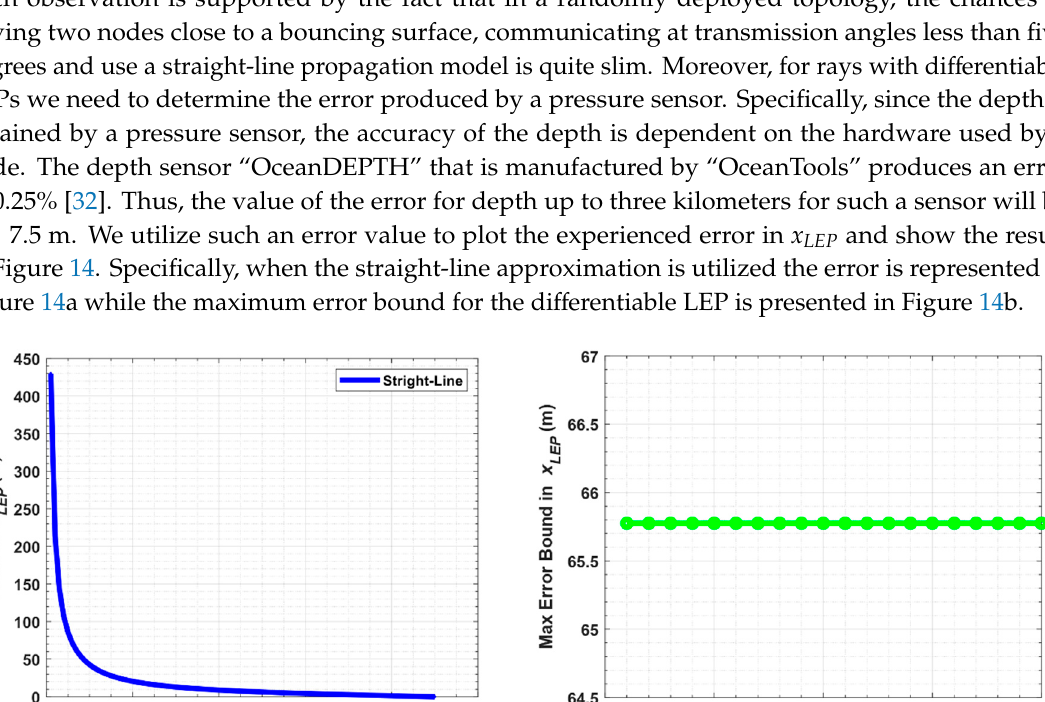
Figure 14. The error observed in the 𝑥 (cid:3013)(cid:3006)(cid:3017) where ( a ) is the error when equation (5) used while ( b ) shows the maximum error bound when Equation (6) is used. Both figures assume that the error by the shows the maximum error bound when equation (6) is used. Both figures assume that the error by pressure sensor is e = 7.5 the pressure sensor is 𝑒 = 7.5 meters.